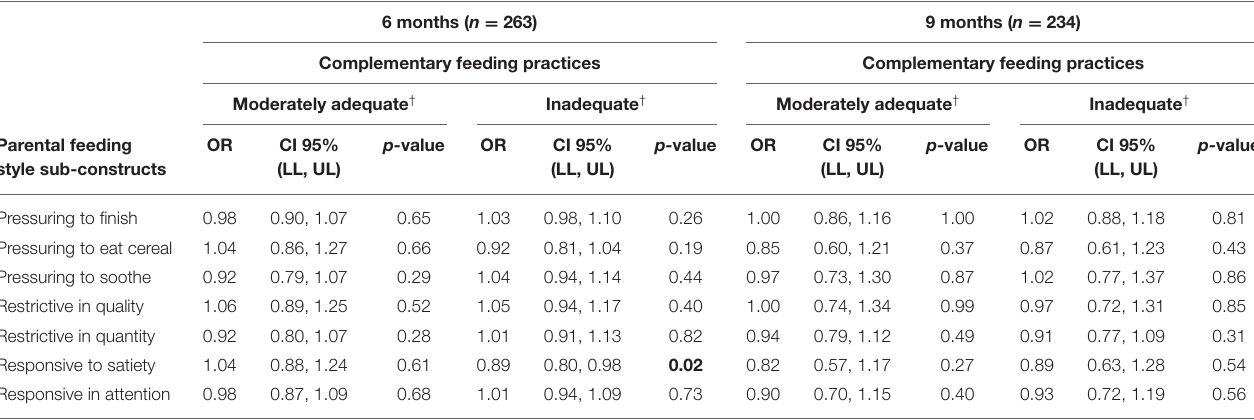
TABLE 3 | Association between parental feeding style sub-constructs and complementary feeding